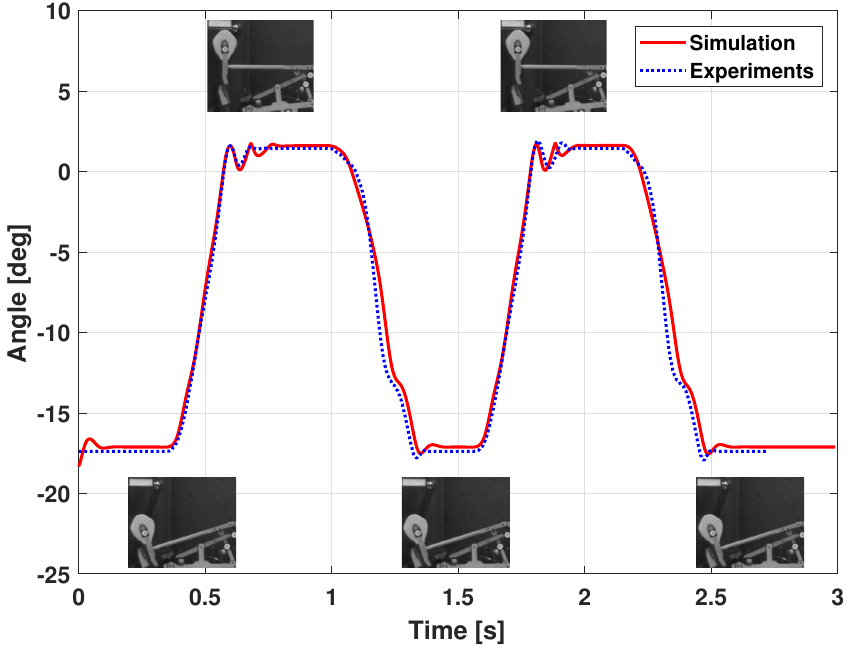
Figure 14. Piano action model dynamic validation: hammer joint position (slow double keystroke). Results of the measured force versus the offline model-simulated force are shown in Figure 15. A double blow pattern is visible, the first key strike starting around 0.3 s and the second around 1.5 s. In both cases, the force starts by increasing, with oscillations, until a quasi steady-state value close to 3 N. Then, when the key is released—around 0.9 s and 2.1 s—the action returns to its resting position, with forces peaks due to the hammer rebound, whose mass and inertia dynamic contributions are relatively high compared to other